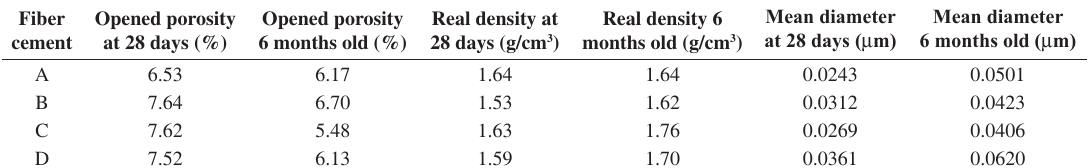
Table 13. Results from porosimetry